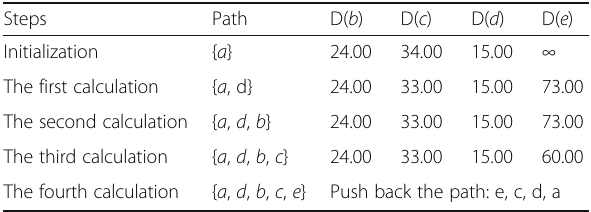
Table 1 The shortest distance calculation process between node a to node